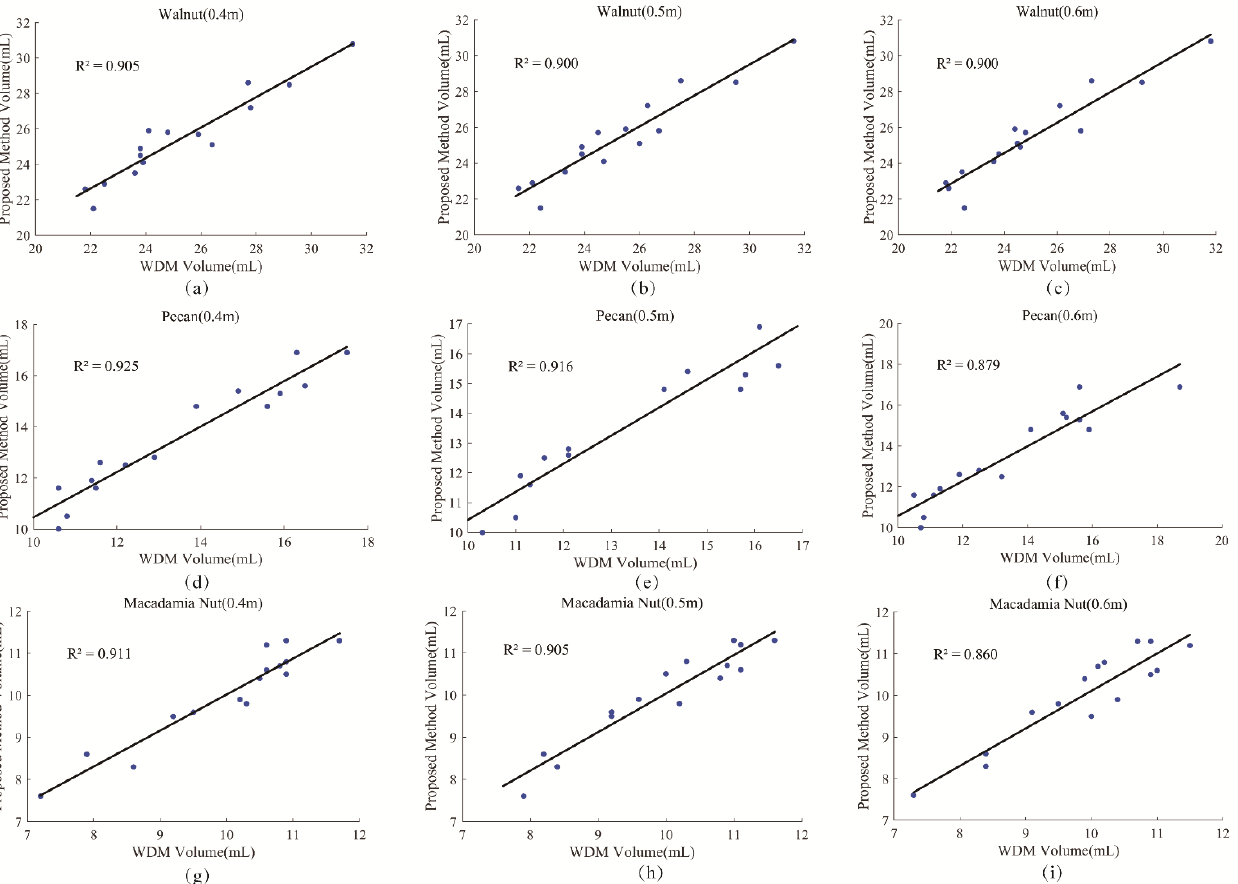
Figure 12. Comparison of estimated and measured volume of various nuts with the proposed method and the WDM at different heights. (a-c) Comparison of estimated and measured volume of Walnuts at the heights of 0.4 m, 0.5 m, and 0.6 m; (d-f) Comparison of estimated and measured volume of Pecans at the heights of 0.4 m, 0.5 m, and 0.6 m; (g-i) Comparison of estimated and measured Table 2. Summary of the volume accuracy of the